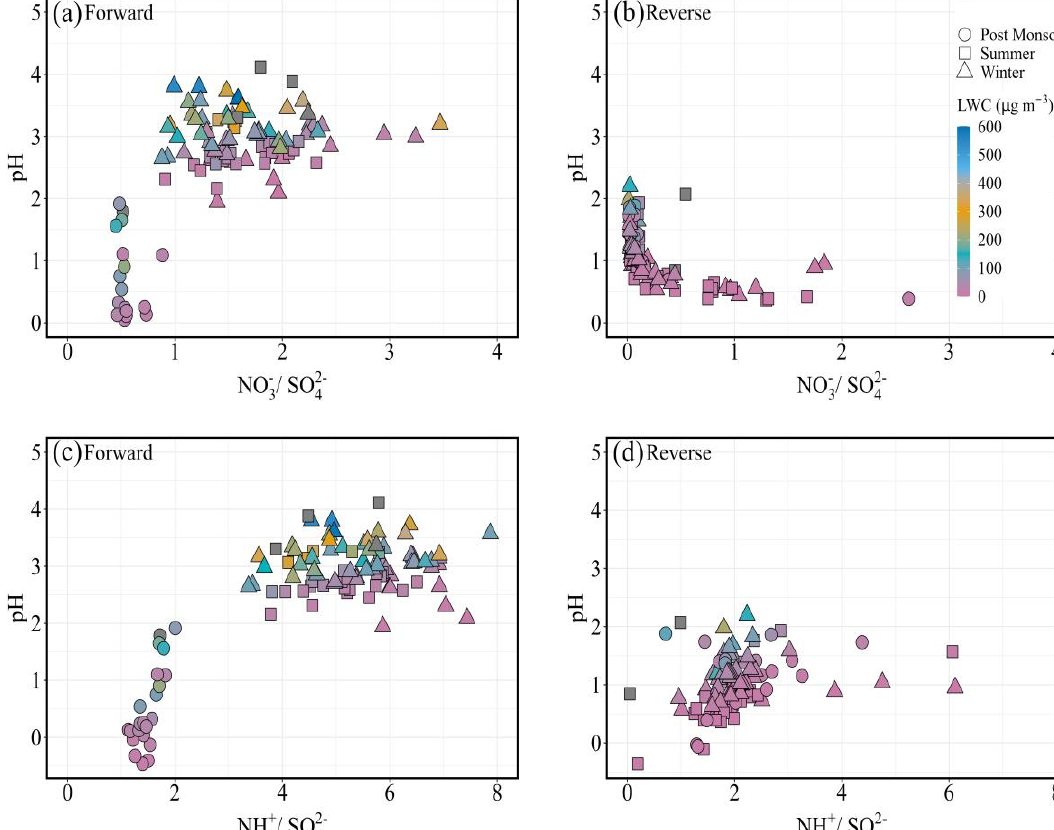
Figure 5. Aerosol pH as a function of ( a ) nitrate to sulfate molar ratio in forward mode; ( b ) nitrate to sulfate molar ratio in reverse mode; ( c ) ammonium to sulfate molar ratio in forward mode; ( d ) ammonium to sulfate molar ratio in reverse mode.